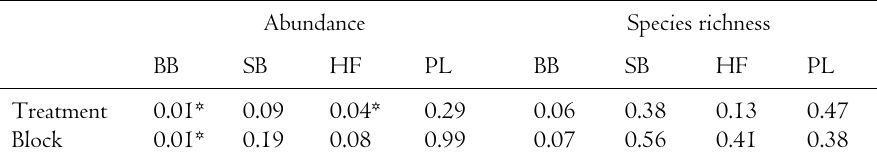
Results from ANOVA randomised complete block to compare abundance and species richness of insects captured in pan traps between treatments ( S. repens present vs. S. repens absent), in four replicate blocks (pairs of sites). BB = bumblebees, SB = solitary bees, HF = hoverflies, PL = plants, * = P <